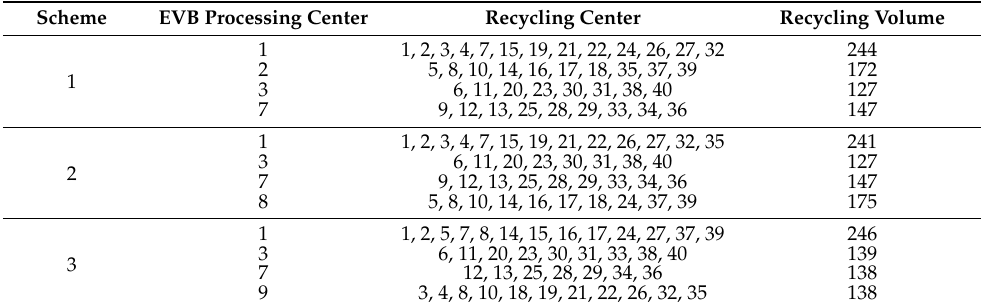
Table 7. Secondary clustering results for each